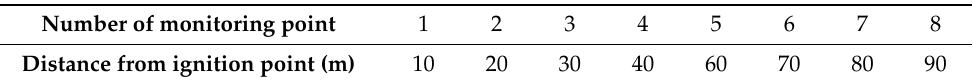
Figure 5. Roadway model. Table 1. Distance between monitoring point and ignition